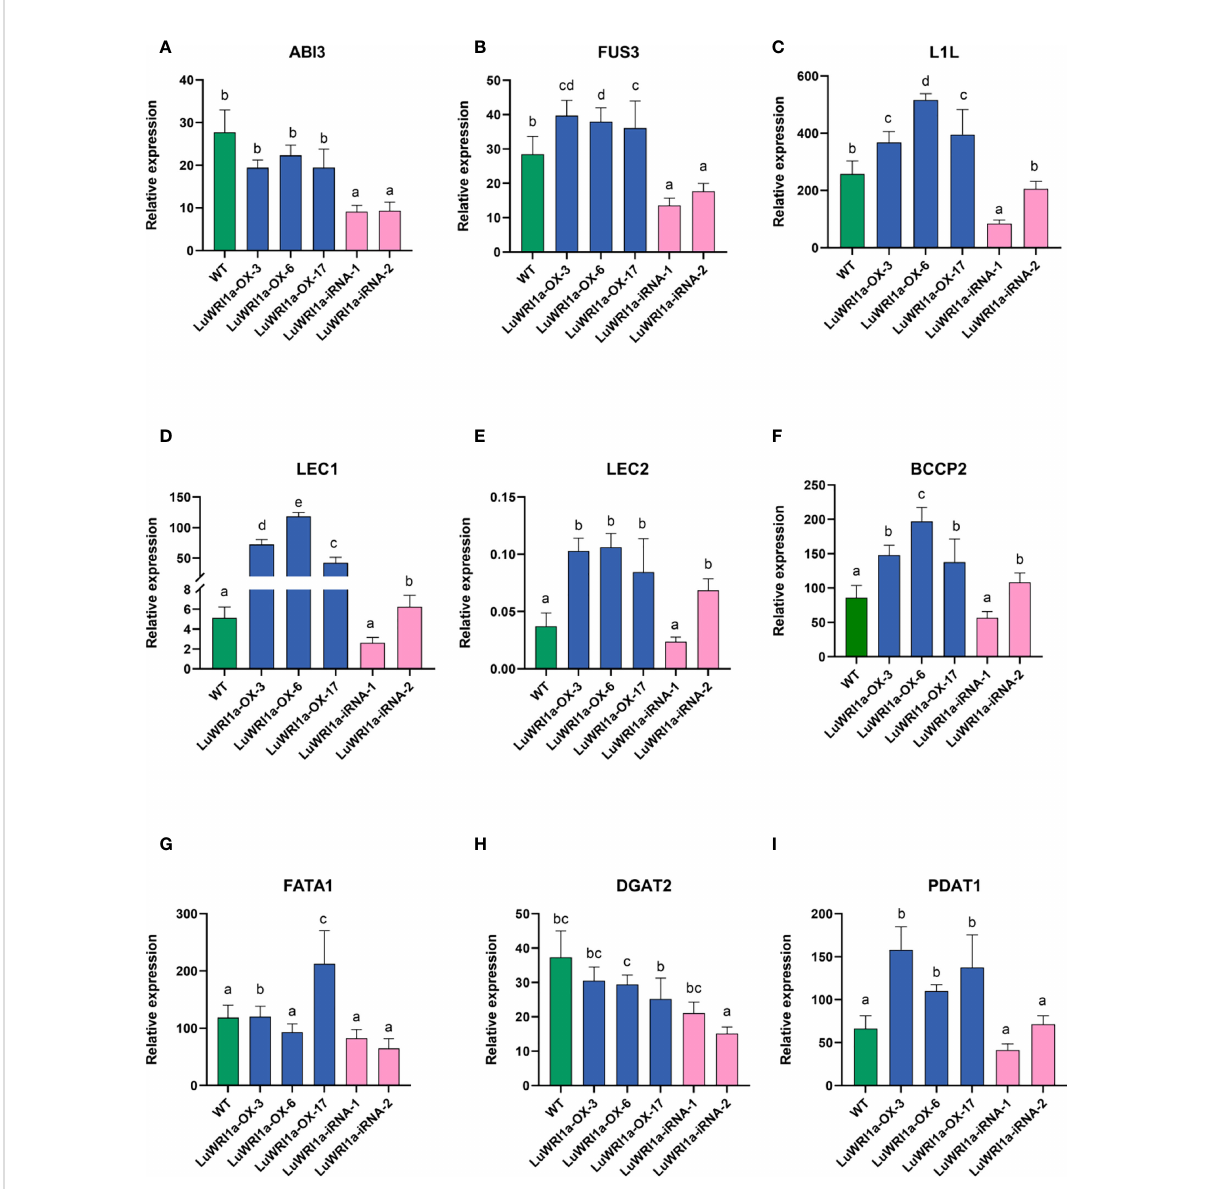
FIGURE 7 Relative gene expression levels of the ABI3 (A) , FUS3 (B) , L1L (C) , LEC1 (D) , LEC2 (E) , BCCP2 (F) , FATA1 (G) , DGAT2 (H) , and PDAT1 (I) in WT, LuWRI1a-OX-X , and LuWRI1a-iRNA-X . The expression of GAPDH was used as an internal reference, and the results were standardized relative to that. Error bars represent SD (n =